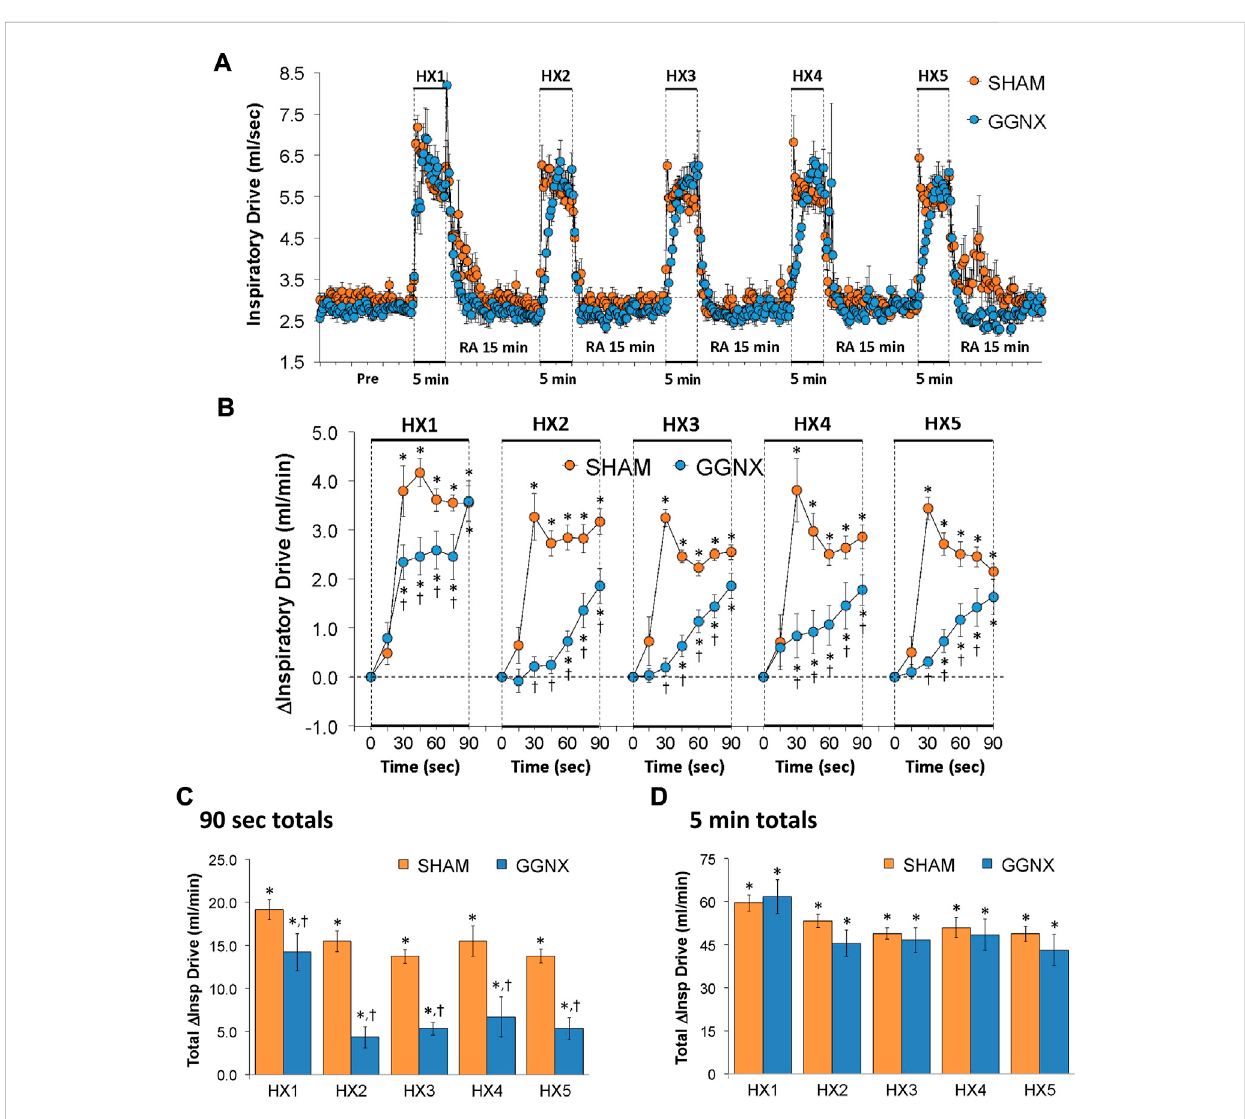
FIGURE 12 (A) Inspiratory Drive (Insp Drive) values in sham-operated (SHAM) rats and in rats with bilateral ganglioglomerular nerve transection (GGNX) before (Pre) and during fi ve hypoxic (HX, 10% O 2 , 90% N 2 ) gas challenges, each separated by 15 min of room-air (RA). (B) Arithmetic changes in Inspiratory Drive during the fi rst 90 s of HX gas challenge. Total changes in Inspiratory Drive during the fi rst 90 s (C) and over the entire 5 min (D) of HX gas challenge. The SHAM group had 10 rats. The GGNX group had 12 rats. The data are presented as mean ± SEM. * p < 0.05, signi fi cant response. † p < 0.05, GGNX rats versus SHAM